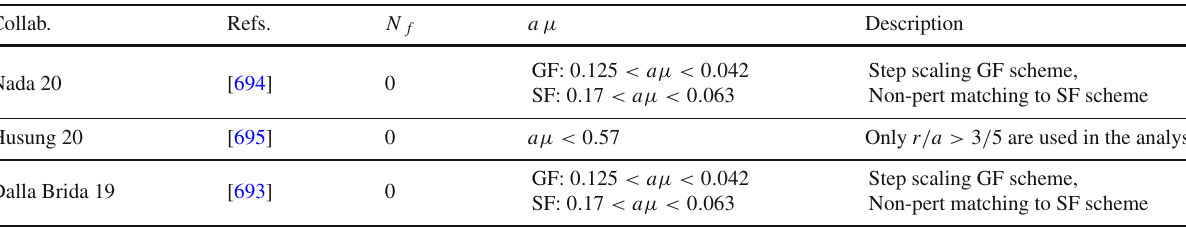
Table 172 Continuum limit for α s determinations with N f = 0 Collab.